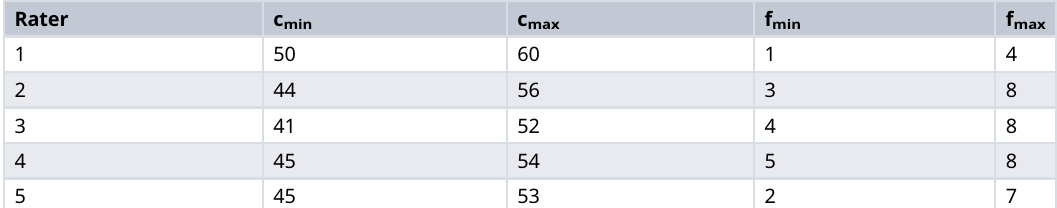
Table1.UsecaseinputparametersforHofsteeCalcRealDataClass01.csv, wherec min isminimumcut-offscore, c max is maximum cut-off score, f min is the lowest percentage of students that the judge feels should fail, and f max is the highest percentage of students that the judge feels should fail.